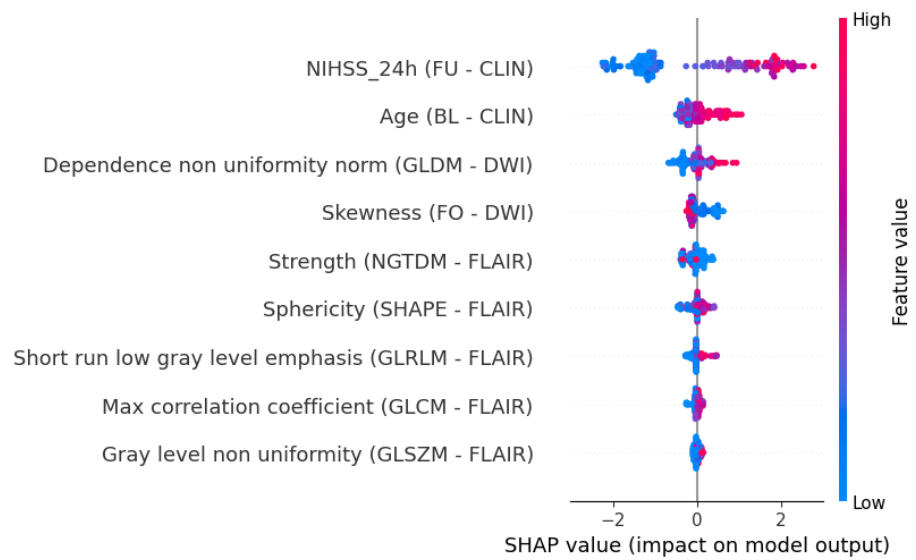
Figure 7. SHAP value beeswarm plot of the most relevant predictors on the test sets. Features are sorted according to their impact on model output. Positive and negative SHAP values are associated with unfavorable and favorable clinical outcomes, respectively. The colors represent the original feature values, with higher values in pink and lower values in blue. For each clinical feature (CLIN), the time of measurement is reported (BL = baseline, FU = follow-up at 24 h). For each radiomic feature, the imaging modality (FLAIR or DWI) and the type of feature are provided in brackets (FO = first order, SHAPE = 2D or 3D shape, NGTDM/GLRLM/GLCM/GLSZM =